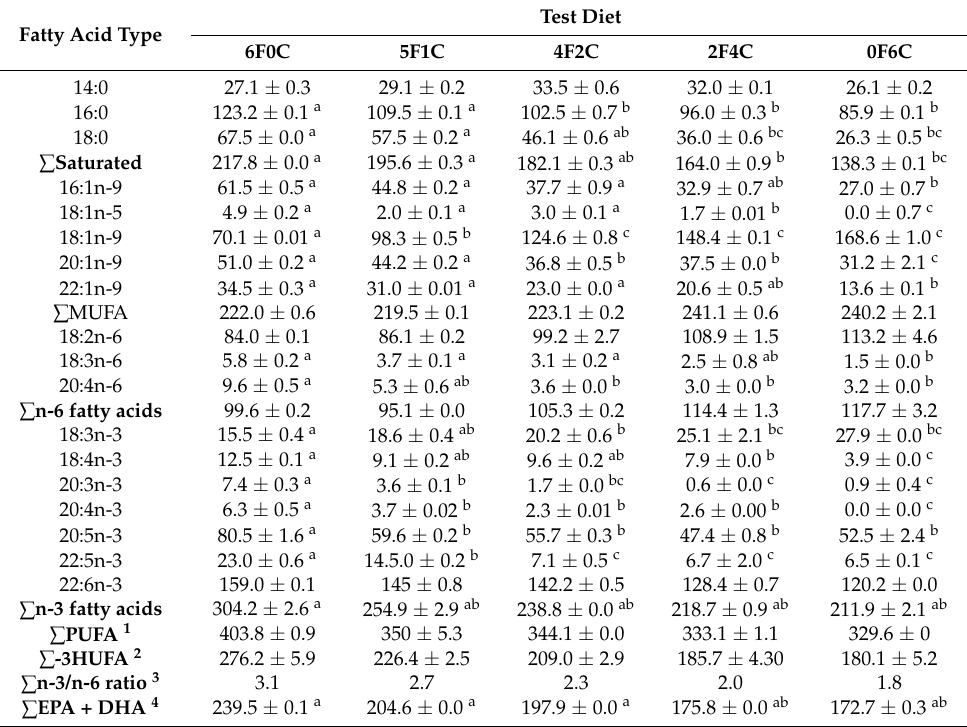
Table 5. Fatty acid composition (mg/g lipid) in the liver of red seabream ( Pagrus major ) fed the experimental diets 56-days.